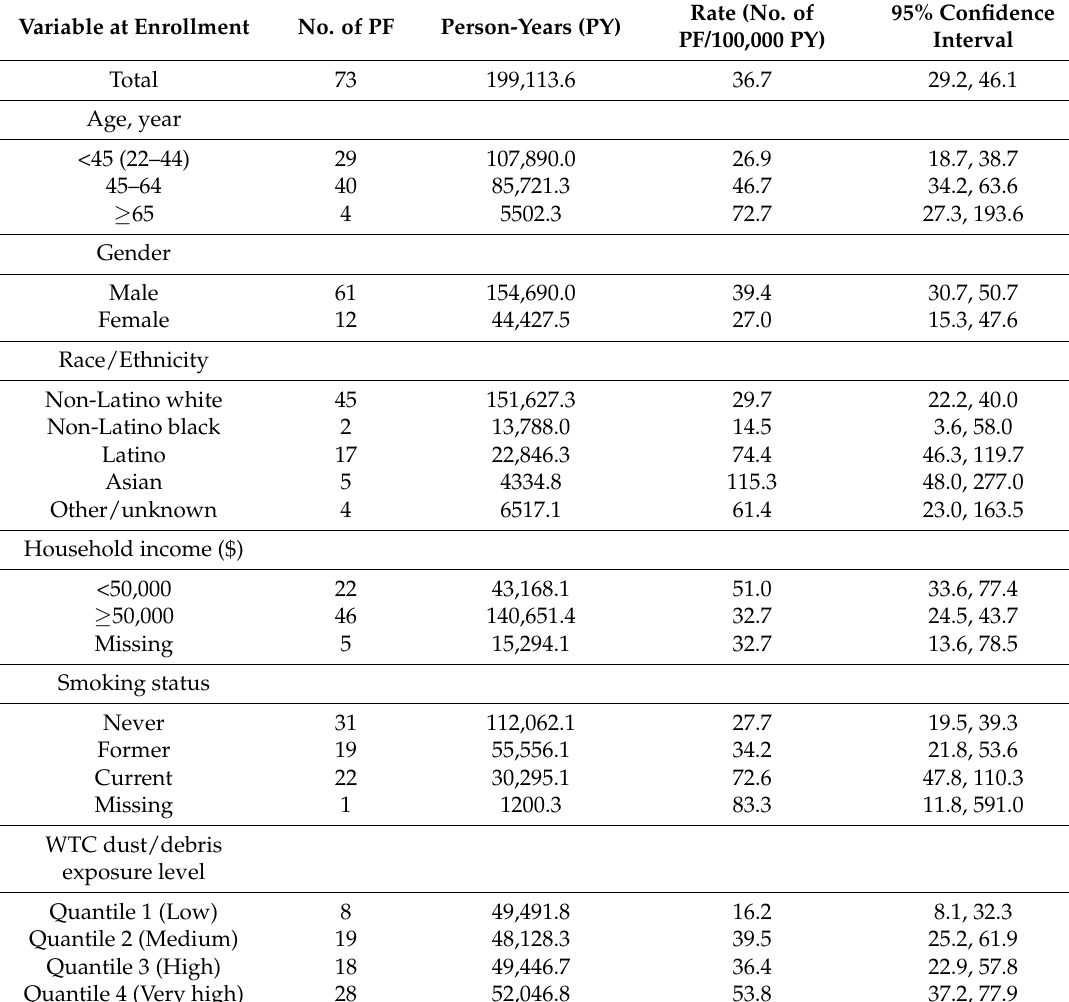
Table 2. Incidence rate of self-reported physician-diagnosed pulmonary fibrosis (PF) according to socio-demographics and WTC dust exposure ( N =